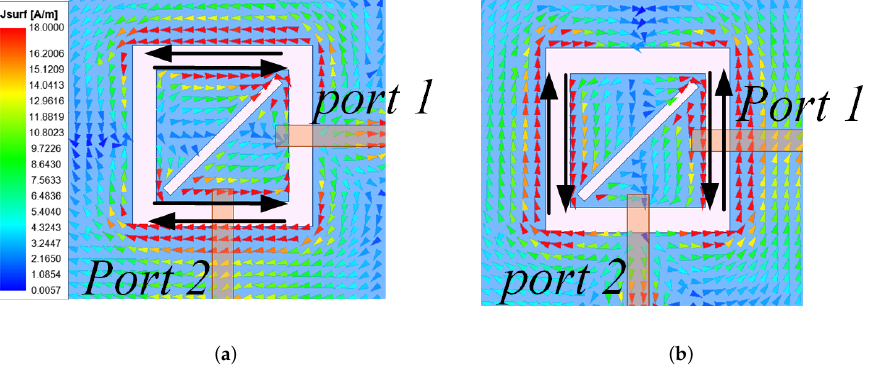
Figure 4. The surface current distributions of the proposed antenna element at 3.5 GHz. ( a ) Port 1. ( b ) Port